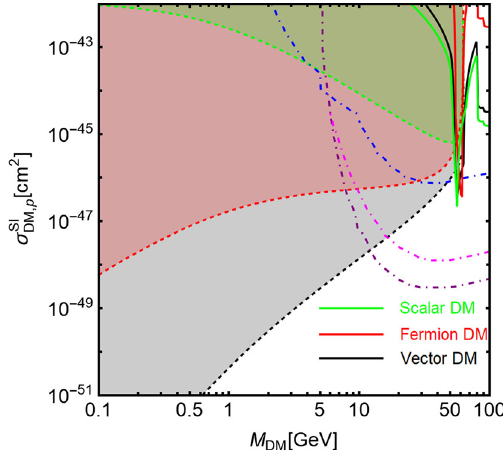
Fig. 2 ComparisonoftheLHCconstraintsfrominvisibleHiggsdecays at the LHC and limits and sensitivities from direct DM detection exper- iments. The dot-dashed blue/magenta/purple curves are for the con- straints from XENON1T and the prospects from XENONnT and DAR- WIN respectively. The colored regions above the dashed lines are excluded regions obtained converting the bound BR ( H → inv ) < 11% into an upper bound on the DM scattering cross section. The green/red/black colours refer to scalar/fermionic/vector DM. Finally the solid lines represent the conversion, according the same color code, of the requirement of the correct relic density into, again, a constraint on the DM scattering